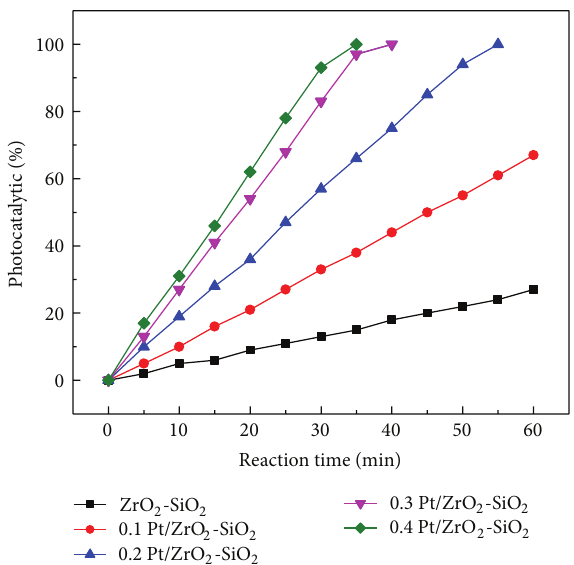
Figure 5: The effect of wt% of Pt on photocatalytic degradation % of CN − with ZrO 2 -SiO 2 and various combinations of Pt/ZrO 2 -SiO 2